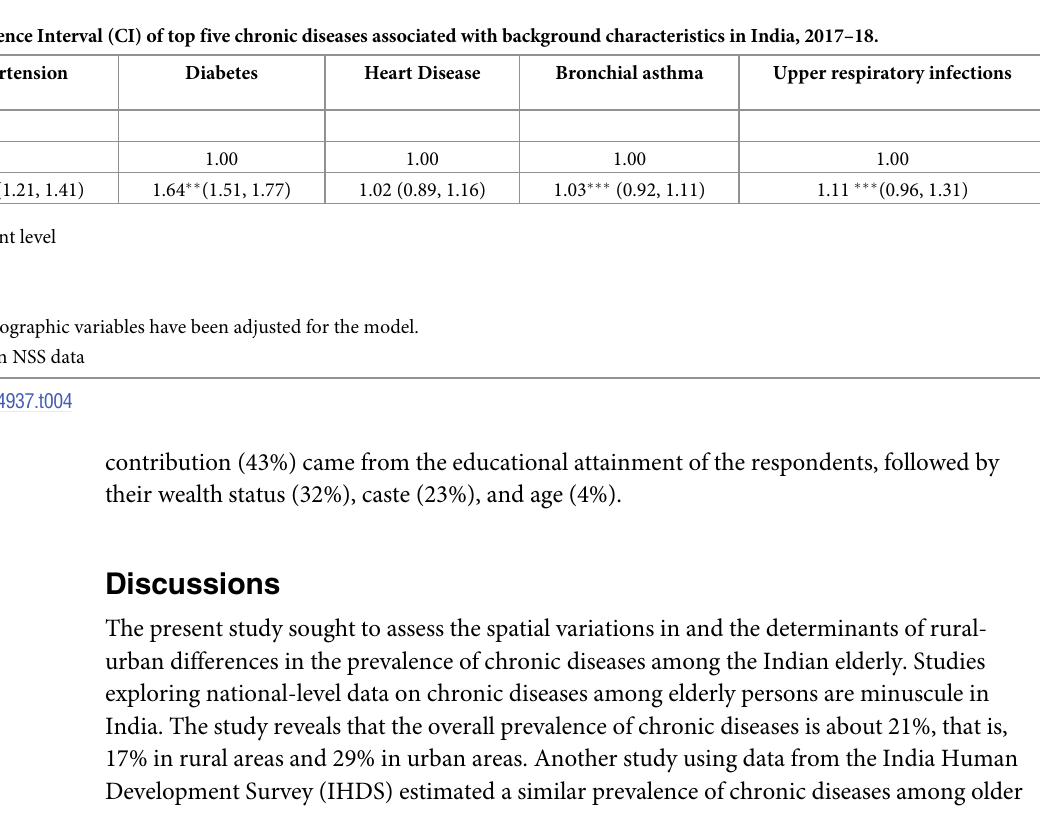
Table 5. Contribution of factors in urban rural differentials in prevalence of chronic disease among elderly in India, 2017–18. Contributing